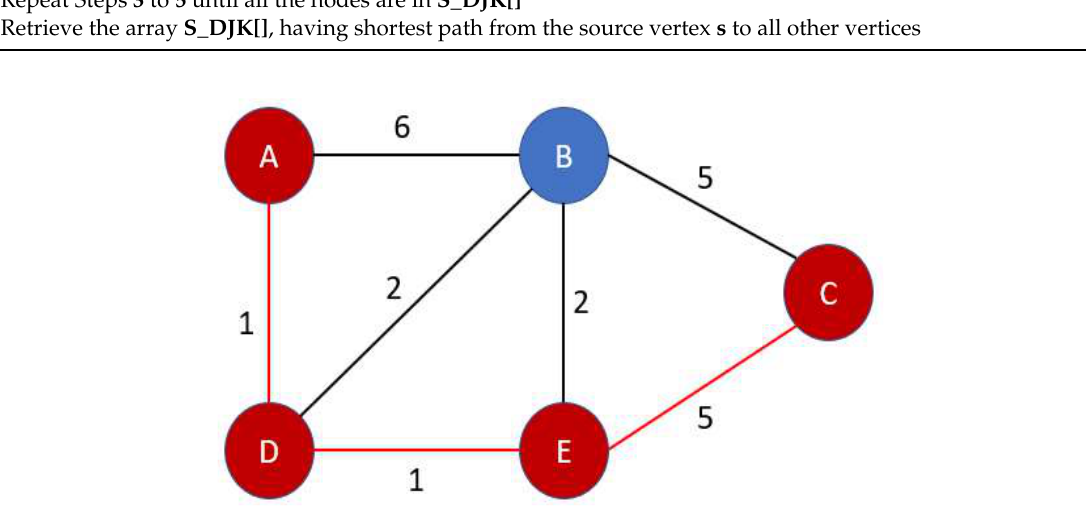
Figure 7. Shortest path using Dijkstra’s Algorithm.